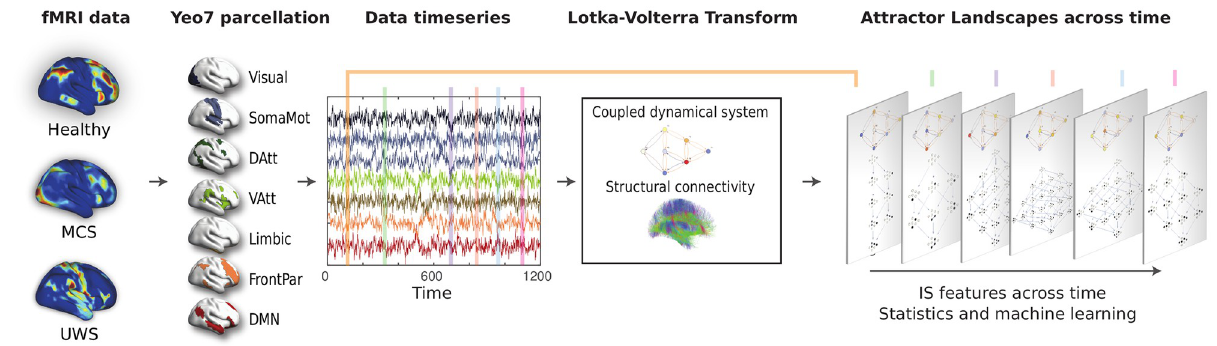
Fig 3. Measuring the changes in the IS underlying brain activity. The brain activity registered through fMRI is mapped into seven brain networks using Yeo’s 7-network parcellation. For each subject, given the timeseries of the activity and the structural connectivity matrix, Lotka-Volterra Transform produces the α values at each instant. This allows the study of the Information Structures evolution in time. Machine learning is used to i train classifiers identifying the state of each subject.